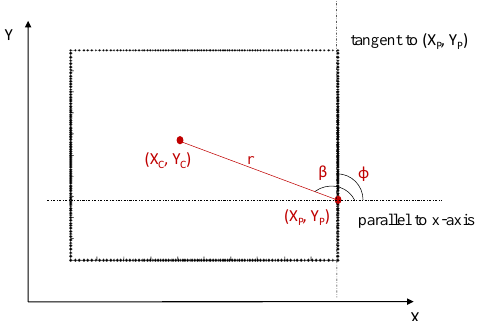
Figure 2. Parameters involved in the GHT for door-candidate detection.